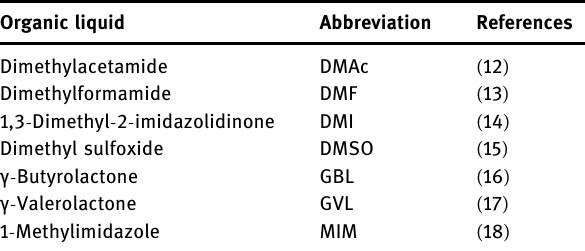
Table 2: Examples of organic liquids utilized as co - solvents for imidazolium - based ionic liquids Organic